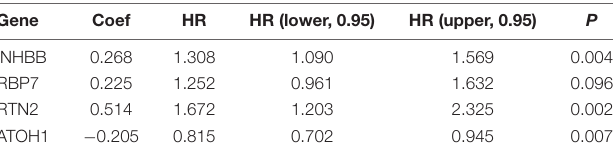
TABLE 2 | Risk factors for the risk model.